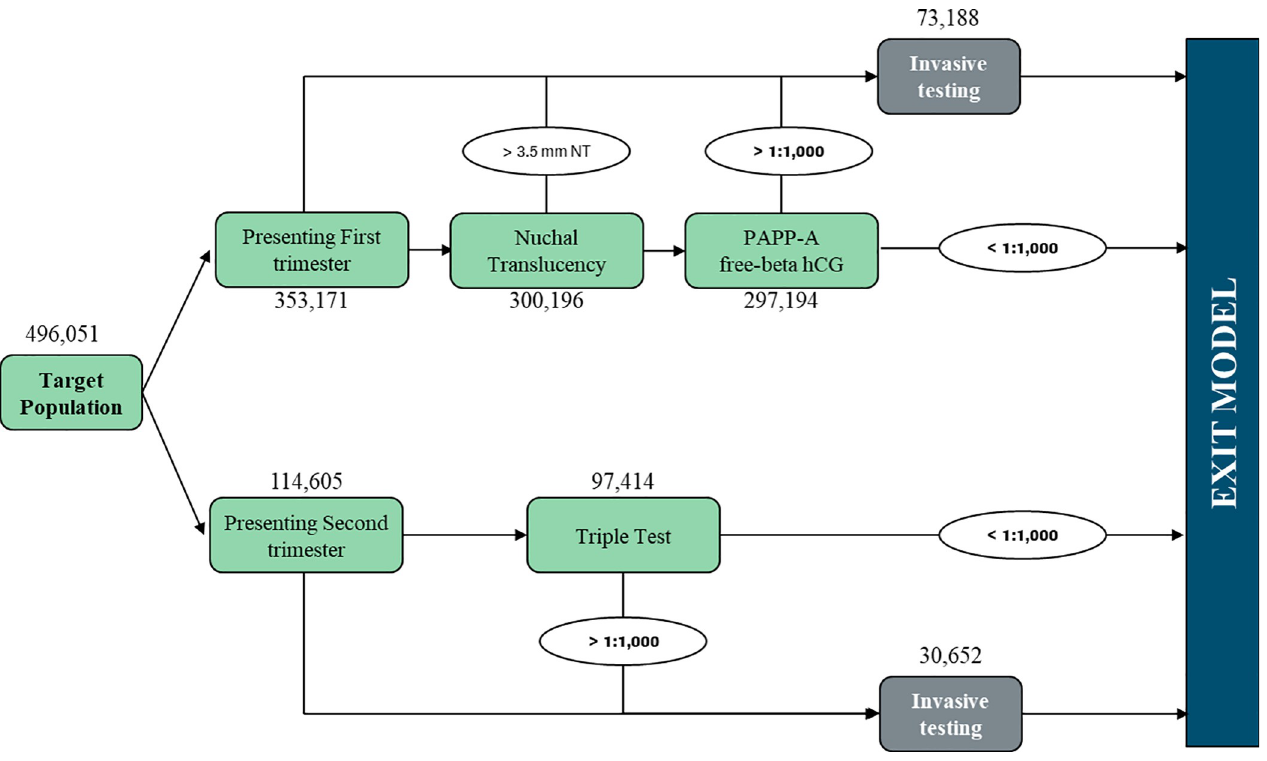
Fig 1. “SoC scenario” patient